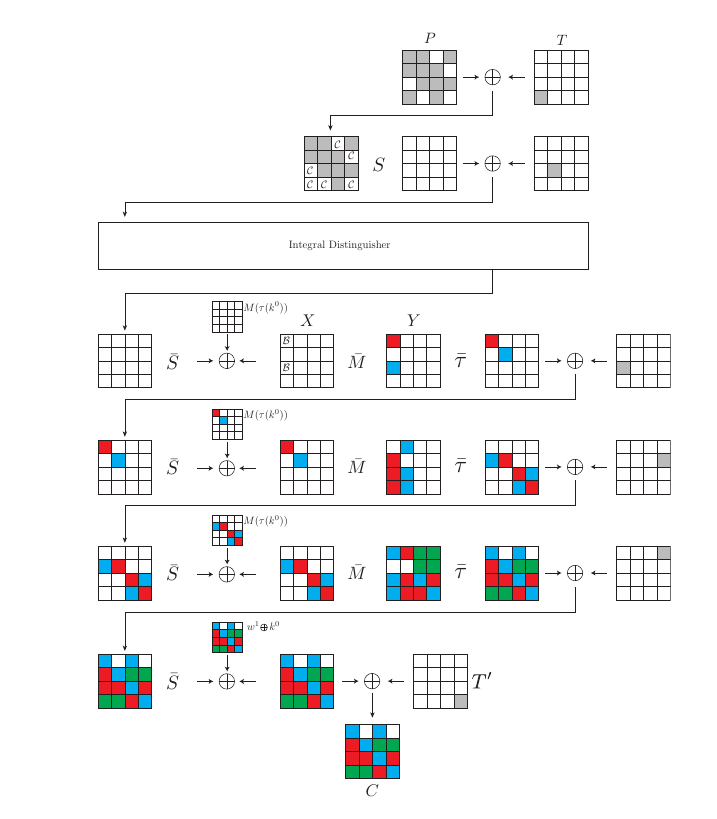
Figure 15: Key-recovery attacks on Qarma 4 , 8